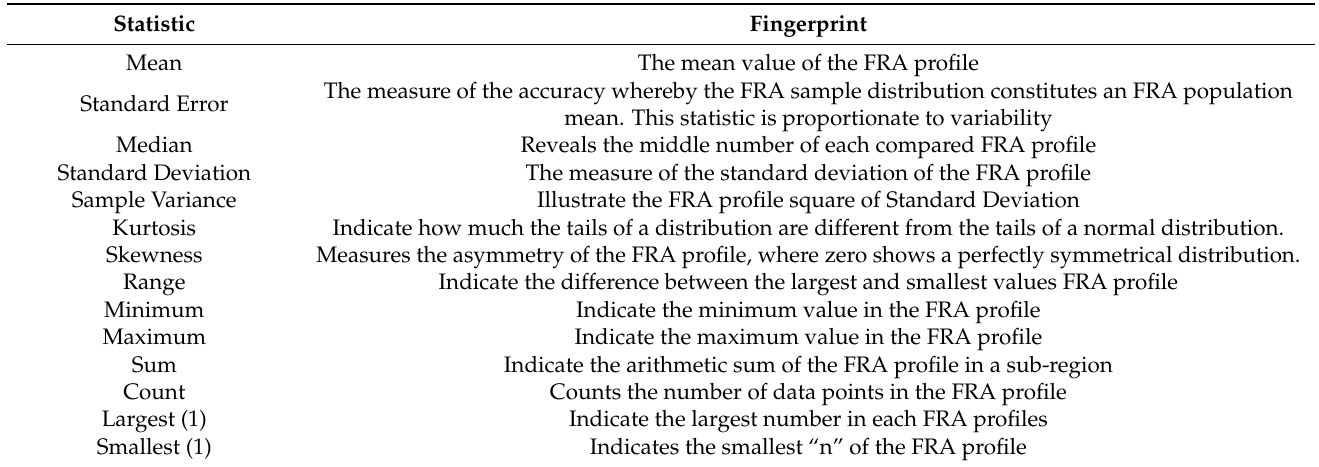
Table 3. Descriptive statistics interpretation for developing an FRA profile interpretation code criteria.